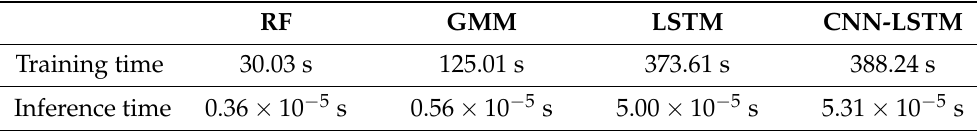
Table 6. Comparison of training time and inference time (per data sample) using various ML